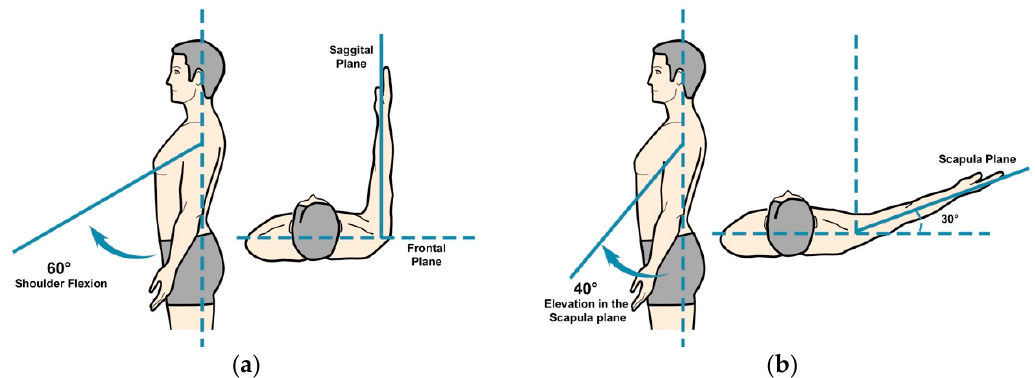
Figure 10. Movement description: ( a ) Shoulder flexion; ( b ) Elevation in scapula plane.